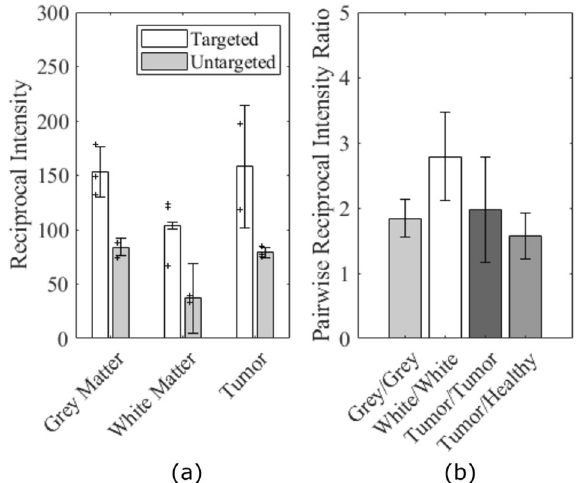
Figure 8. Reciprocal intensity analysis results in LM tumor rats. ( a ) Comparison between FUS targeted and untargeted regions in different tissue types. ( b ) Ratio between paired targeted and untargeted reciprocal intensity values in different tissue types and the ratio between targeted tumor and targeted healthy tissue reciprocal intensities. Error bars show standard